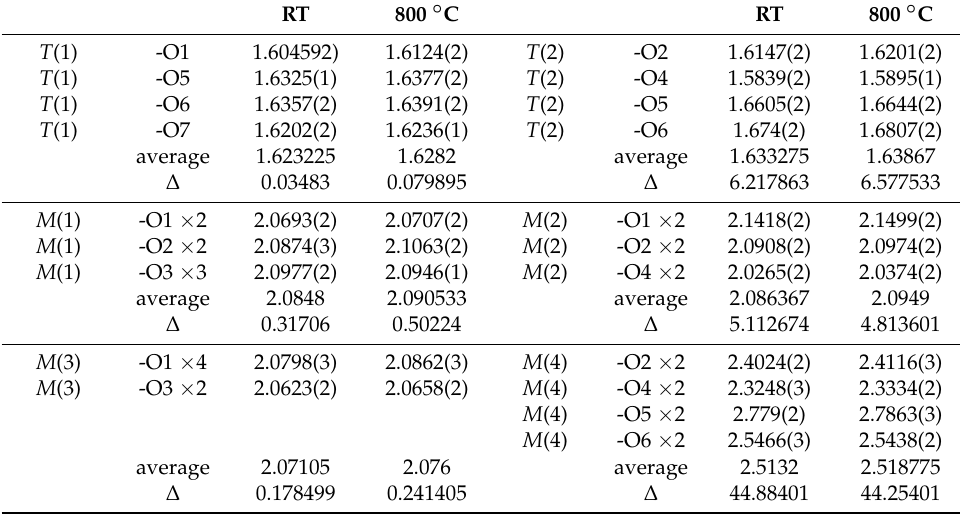
Table 4. Selected bond distances (in Å) for tremolite RT and 800 ◦ C. Polyhedron distortion, ∆ , as and R i an individual bond